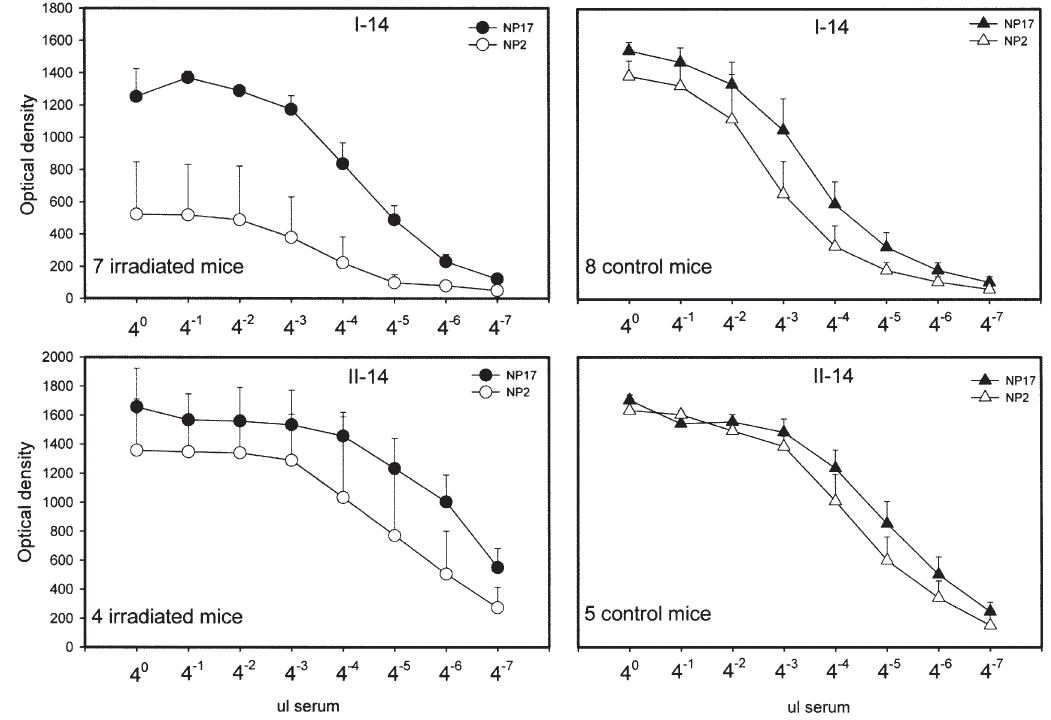
FIGURE 5 Altered affinity maturation process in RX-P.S. mice following irradiation. Sera from groups of 4 to 8 RX-P.S. (circle) and non-RX (triangle) mice immunized with NP-KLH precipitated in Alum were collected at day 14 (I-14) and 14 days after the second stimulation with NP-KLH in PBS (II-14). Results represent mean ^ SEM : Shown are IgGl sera binding curves on NP 17 -BSA vs. NP 2 -BSA. Closed symbols represent binding curves on NP17-BSA and open symbols on